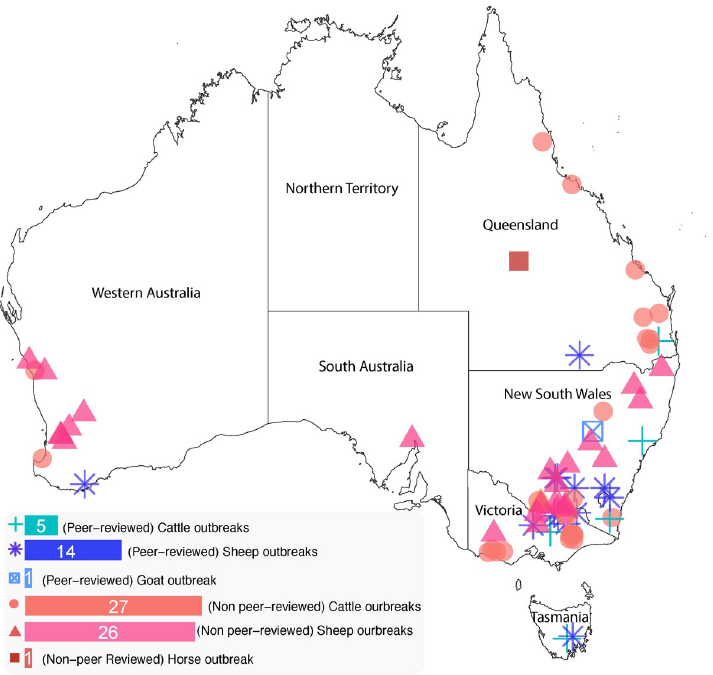
Fig 3. The number of combined peer-reviewed and non peer-reviewed photosensitisation case reports identified by geographical location and species in different states in Australia.